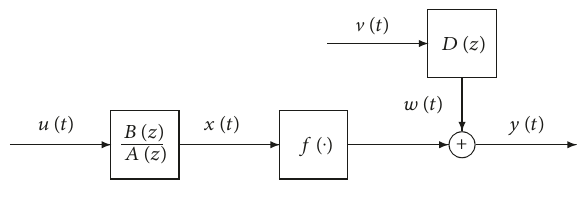
Figure 1: The Wiener system